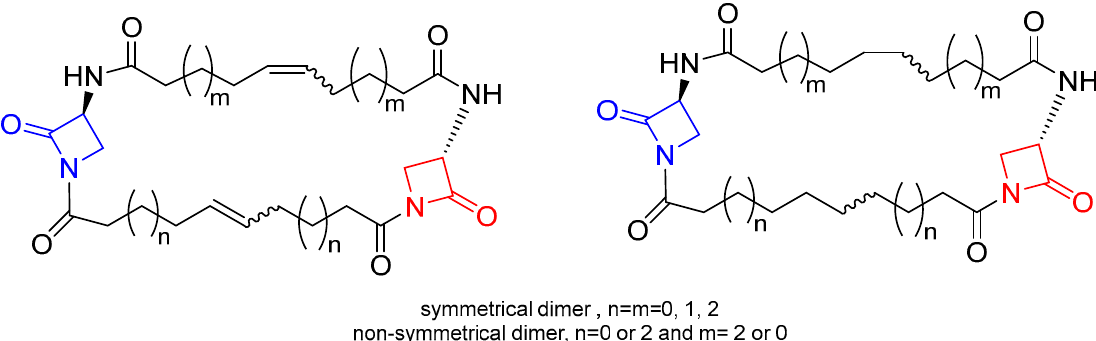
Figure 7. General structures of macrocyclic-embedded β -lactams reported in Ref. [26]. The azetidinone rings embedded in the macrocyclic scaffold are highlighted in red and blue.